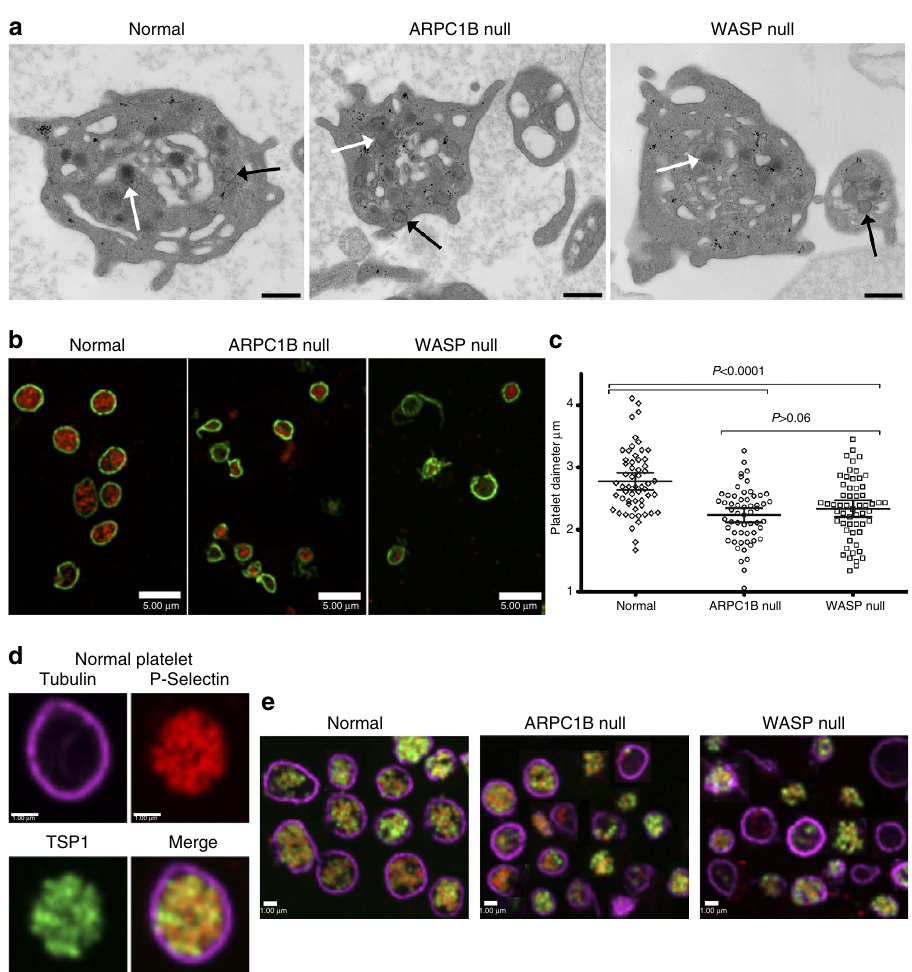
Figure 3 | ARPC1B-null and Wiskott–Aldrich syndrome platelets are similar. ( a ) Transmission electron microscopy (TEM) imaging of sections from normal donor, ARPC1B-null (Patient 1) and WASP-null patient platelets show typical structures including a -granules (white arrows), mitochondria (black arrows) and internal membrane systems (bars ¼ 500nm; see Fig. 4 for further comparisons). ( b ) Immunofluorescence microscopy of cells stained for circumferential ring tubulin (green) and a -granule membrane P-selectin (red) shows that ARPC1B-null and WASP-null platelets appear small and dysmorphic compared to normal (bars ¼ 5 m m). ( c ) A comparison of circumferential ring diameter distributions confirmed that both ARPC1B-null and WASP-null platelets are significantly smaller than normal ( P o 0.0001, unpaired t -test; n ¼ 57 cells; 95% confidence intervals shown) and do not differ significantly from each other. Equivalent comparisons of all patients with WASP-null and normal control platelets is shown in Fig. 5a. ( d ) The morphology of a normal platelet showing the typical subcellular locations of tubulin (magenta), P-selectin (red) and a -granule cargo thrombospondin-1 (TSP1, green; bars ¼ 1 m m). ( e ) Collections of representative cells illustrate the range of abnormal features observed in ARPC1B-null and WASP-null platelets, including small size and the variable absence of internal contents (bars ¼ 1 m